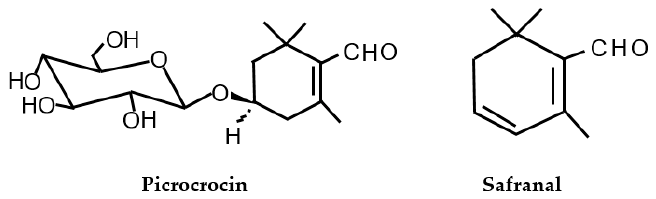
Figure 3. Structures of picrocrocin and safranal found in saffron [6].